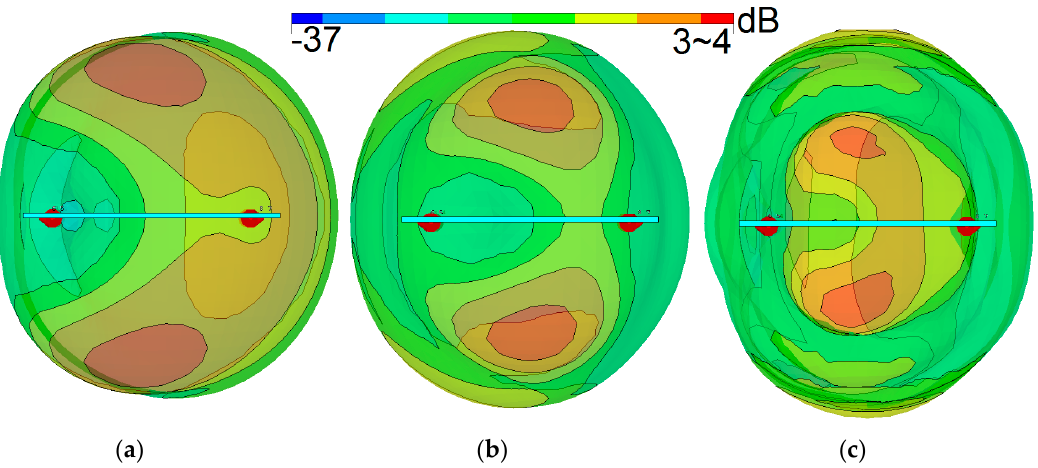
Figure 7. Side views of the antenna radiation patterns at ( a ) first (2.6 GHz), ( b ) second (3.6 GHz), and ( c ) third (5.8 GHz) resonances.